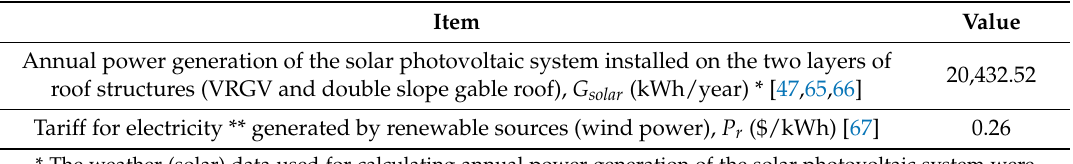
Table 6. Parameters for estimating cash flow of solar photovoltaic power generation. Item